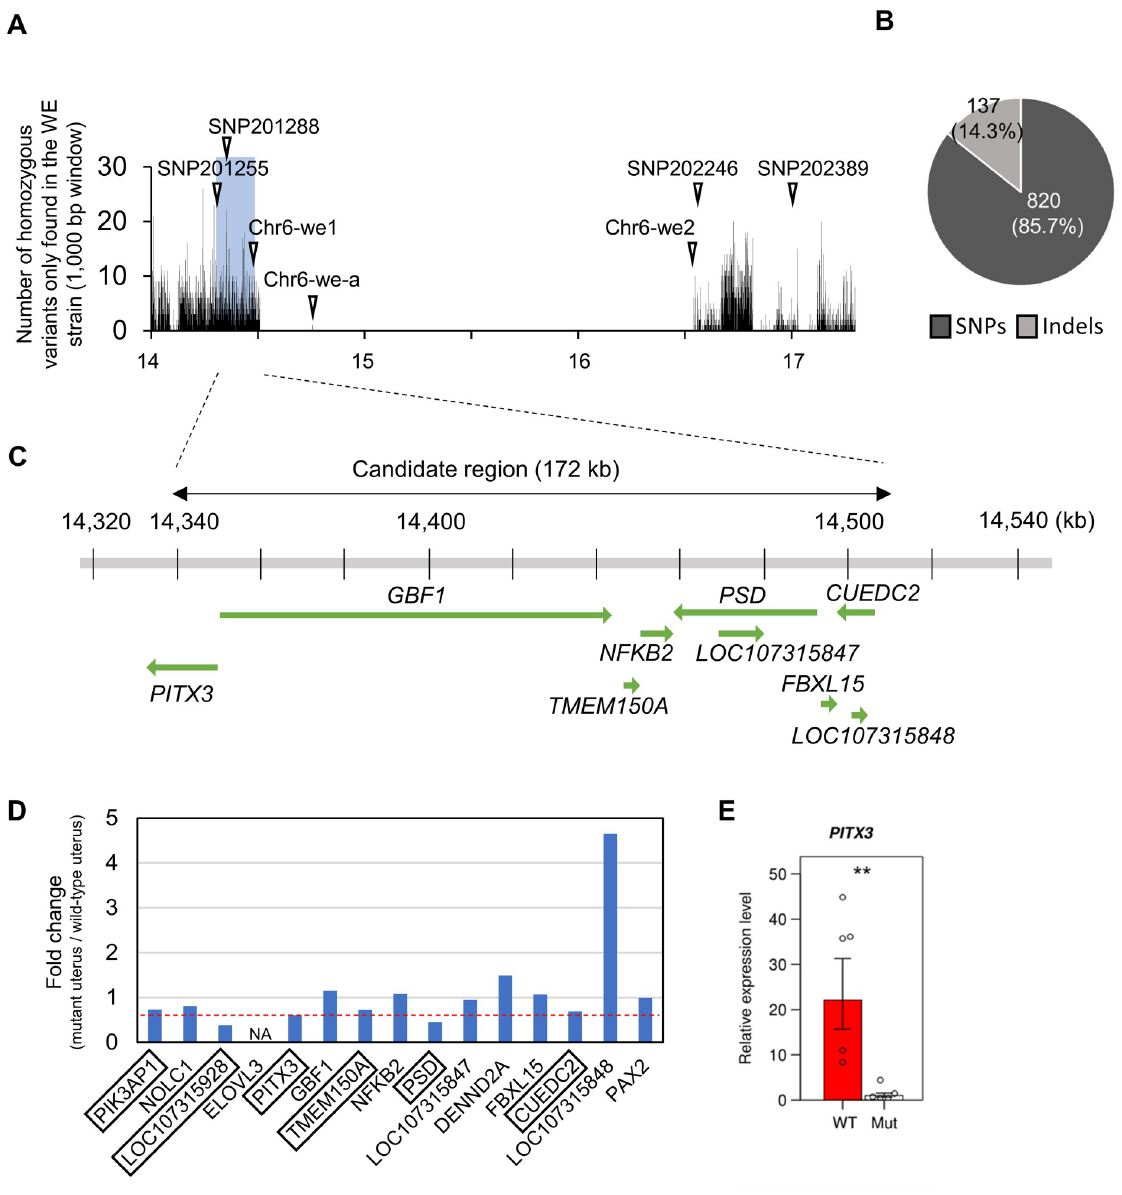
Fig 4. Distribution of sequence variants around the we locus and expression analysis of genes around the 172 kb candidate region. (A) Number of sequence variants that were homozygous in the father quail (WE strain), but not in the mother quail (NIES-L strain), around the we locus. White arrowheads indicate the locations of the SNP markers. (B) Frequencies of SNPs and insertion–deletion mutations (indels) within the 172 kb candidate region. (C) Eight genes and a part of paired-like homeodomain 3 ( PITX3 ) that are harbored in the 172 kb candidate region (green arrows). (D) Relative expression levels of 15 genes (located around the 172 kb candidate region) in the mutant uteri against those in the wild-type uteri. NA denotes genes whose expression was not detected in the wild-type uteri. Expression levels of six genes (enclosed in squares) substantially decreased in the mutant uteri (less than 60–70% of those in the wild-type uteri). (E) Graphs showing the results of qPCR analysis of PITX3 using RNA samples ( n = 5 for both wild-type and mutant quails) that were not used for mRNA sequencing. The expression levels in the wild-type uterus are shown relative to those in the mutant uterus defined as 1. The expression level in each sample is shown by a circle. �� p < 0.01.